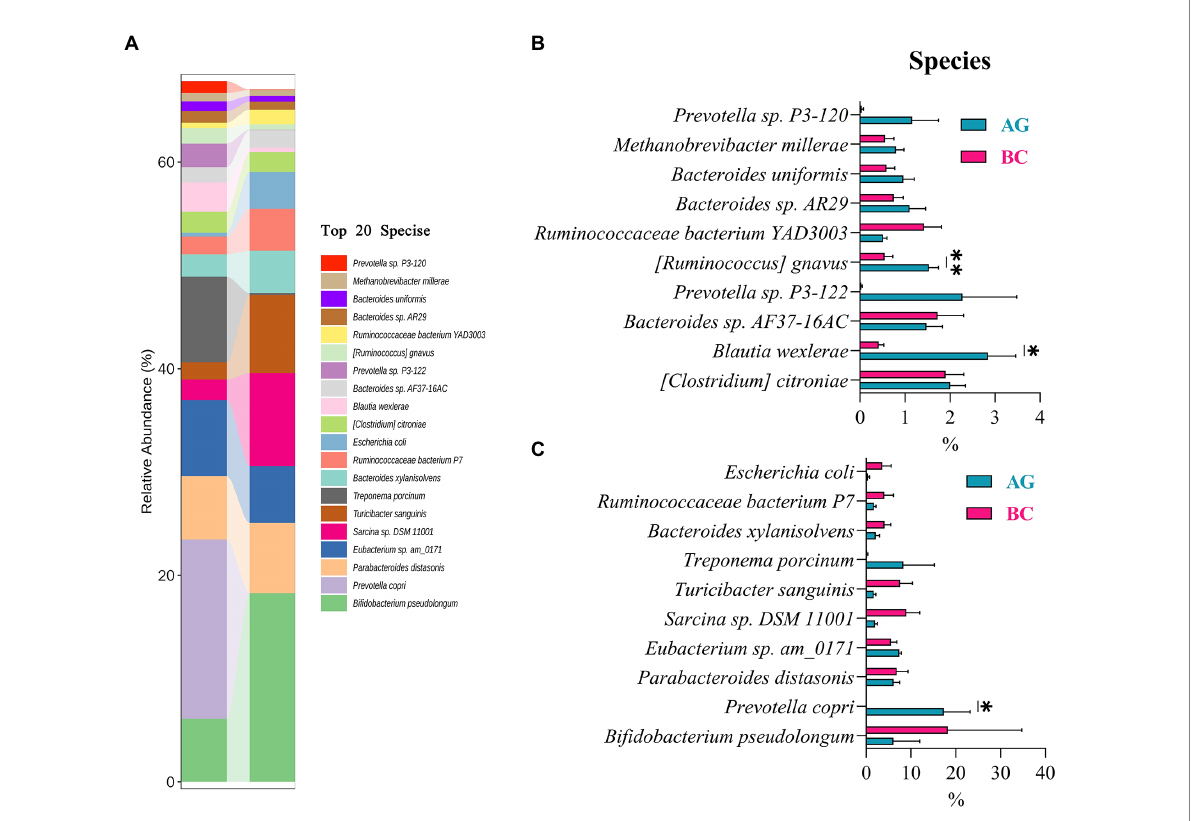
FIGURE 7 The species composition and the differentials in the gut microbiota between Xinjiang brown cattle (BC) and Angus cattle (AG; top 20 species). ( n = 5 in each breed). The relative abundance of species composition (A) ; The differential species in the different relative abundance (B,C) . Values were expressed as means ± SEM. * denotes p < 0.05 indicating significant difference, ** denotes p < 0.01 indicating extremely significant